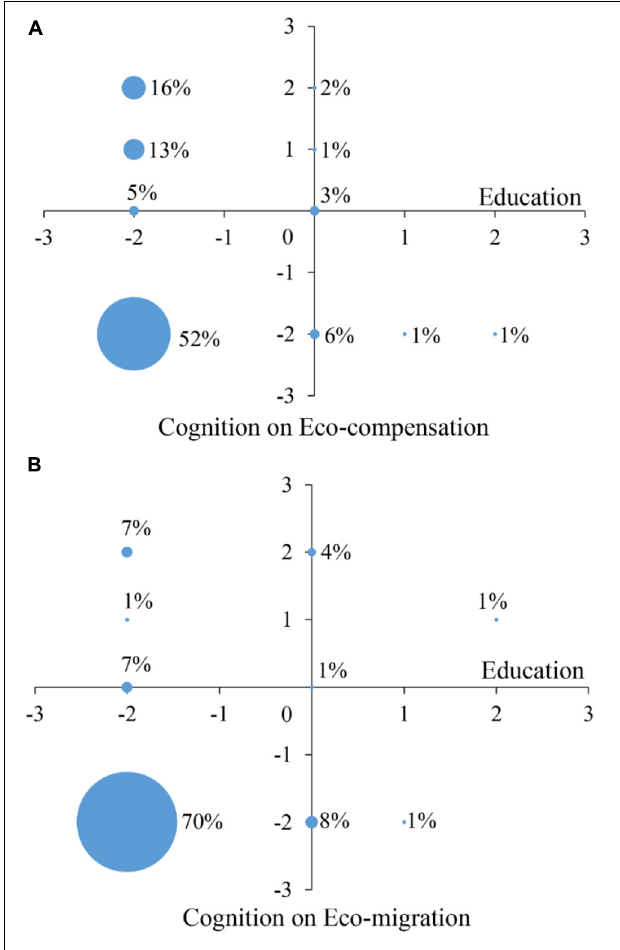
FIGURE 6 | Cognition on eco-compensation (A) and eco-migration (B) of households with different education levels in the SNP. Education level: -2 stands for uneducated; -1 stands for temple education; 0 (zero) stands for primary school; 1 stands for middle school; and 2 stands for high school or above. The cognition on eco-compensation and eco-migration policies: -2 stands for against; -1 stands for mixed; 0 (zero) stands for no idea; 1 stands for medium; and 2 stands for support.